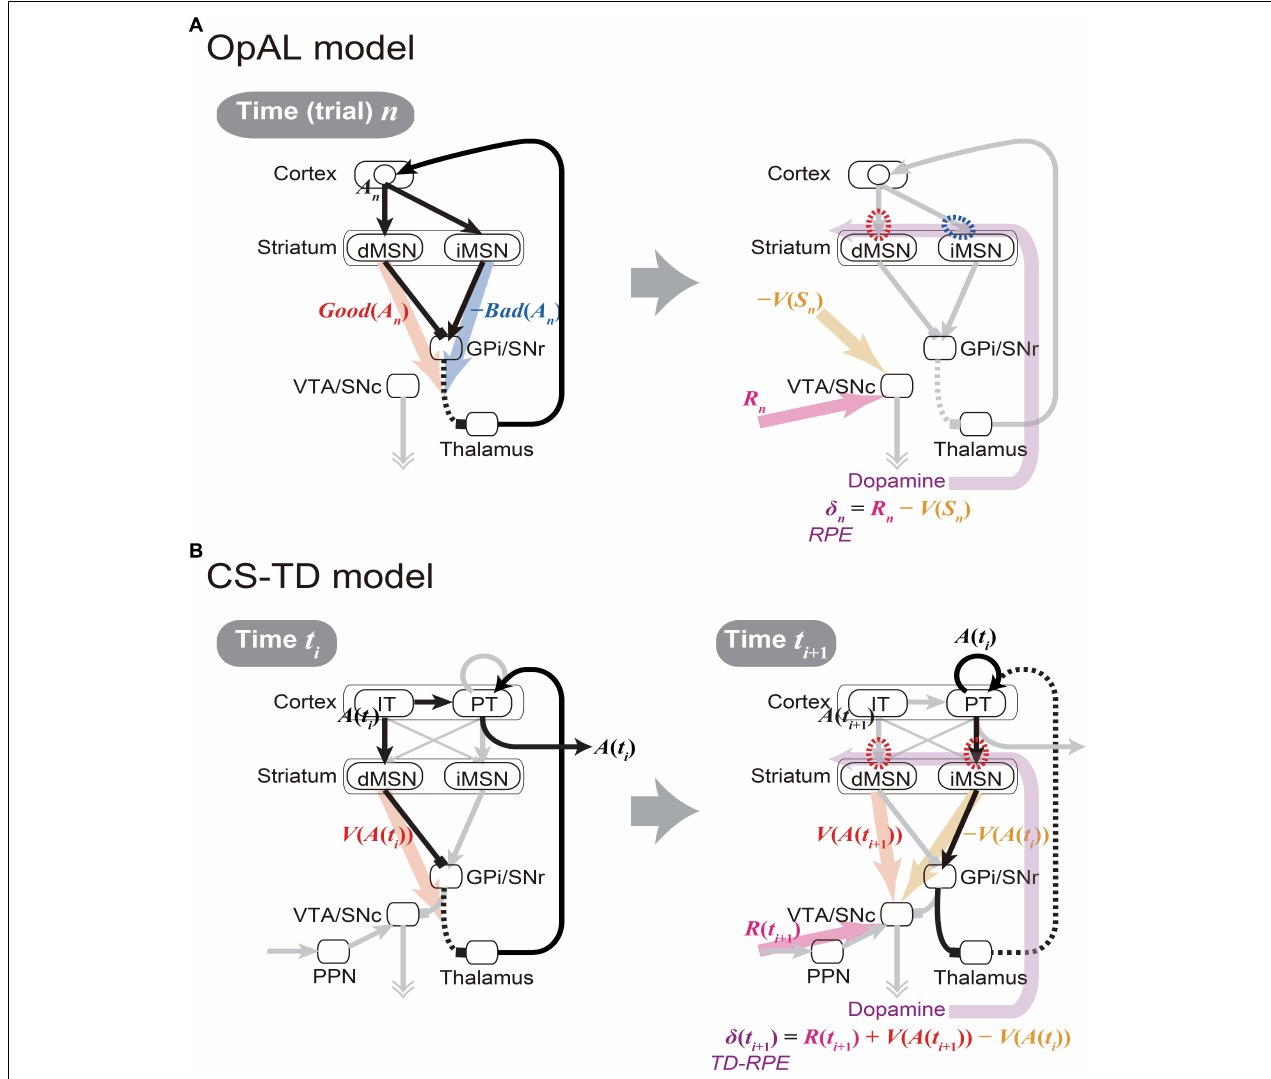
FIGURE 1 | Existing models of the cortico-basal ganglia circuit functions. (A) Our sketch of the Opponent Actor Learning (OpAL) model (Collins and Frank, 2014), using our own terms and notations. ( Left panel ) At time (or trial) n , goodness (benefit) and badness (cost) of action A n [ Good ( A n ) and Bad ( A n )] are represented by the activities of striatal direct and indirect pathway medium spiny neurons (dMSNs and iMSNs), respectively. When there are multiple action candidates, one action is selected based on the utility: Good ( A n ) − Bad ( A n ), in a soft-max manner. More precisely, in the OpAL model, corticostriatal synaptic weights into dMSNs and iMSNs are defined as Go and NoGo weights ( G and N ), respectively, and activations of dMSNs and iMSNs are considered to be β G G and β N N , where β G and β N are parameters varying depending on DA (see Collins and Frank, 2014 for details): Good ( A n ) and Bad ( A n ) above correspond to β G G and β N N , respectively. ( Right panel ) As an outcome of action A n , reward R n is obtained, and reward prediction error (RPE): δ n = R n − V ( S n ) is represented by the dopamine (DA) neurons, where V ( S n ) is the value of state S n . When RPE is positive, the cortex-dMSN connections are potentiated (red dashed oval) whereas the cortex-iMSN connections are depressed (blue dashed oval). These contrasting plasticity inductions in turn lead to the opponent representations of goodness (benefit) and badness (cost) by dMSNs and iMSNs, respectively. Notably, there are aspects of this model that are not illustrated here; please refer to the original literature (Collins and Frank, 2014). (B) The Cortico-Striatal-Temporal-Difference (CS-TD) model (Morita et al., 2012; Morita, 2014). ( Left panel ) At time t i , action A ( t i ) is represented in the cortical intratelencephalic (IT) neurons, and its value [ V ( A ( t i ))] is represented by dMSNs. The information of action is transmitted to the cortical pyramidal-tract (PT) neurons, through the unidirectional IT → PT connections and also through the output nuclei of the basal ganglia [the substantia nigra pars reticulata (SNr) and the globus pallidus internus (GPi)] and the thalamus, and one action is selected in a soft-max manner when there are multiple action candidates. The action is then executed through the pyramidal tract. ( Right panel ) At time t i + 1 , PT neurons sustain the information of the executed action A ( t i ) via facilitatory recurrent excitation, and activate iMSNs via facilitatory connections so that iMSNs represent the value of the executed action [ V ( A ( t i ))]. Meanwhile, dMSNs represent the value of the upcoming action [ V ( A ( t i + 1 ))], in the same way as at time t i . The DA neurons receive positive and negative impacts from dMSNs and iMSNs, respectively, through the SNr → SNc connections. The DA neurons also receive the information of the obtained reward R ( t i + 1 ) through the pedunculopontine tegmental nucleus (PPN), and thereby calculate the temporal difference (TD) RPE: δ ( t i + 1 ) = R ( t i + 1 ) + V ( A ( t i + 1 )) − V ( A ( t i )). When TD-RPE is positive, the IT-dMSN connections and the PT-iMSN connections are both potentiated (red dashed ovals). These plasticity inductions in the same direction in turn lead to the parallel representations of action value, albeit with temporal difference, by dMSNs and